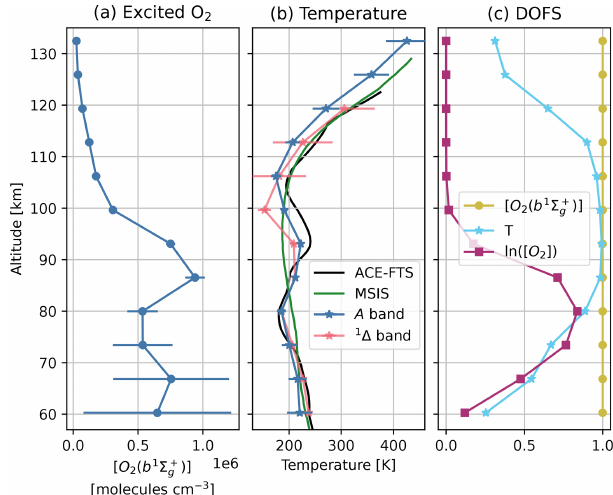
Figure 7. Similar to Fig. 5 but in the A band. The A -band-derived emission of the O 2 number density and temperature are shown in blue. In panel (b) , the 1 (cid:49) -band-derived temperature, the same one shown in Fig. 5b, is overlaid in